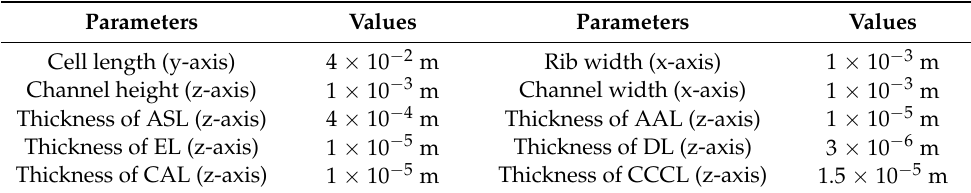
Table 4. Geometrical parameters of simulation